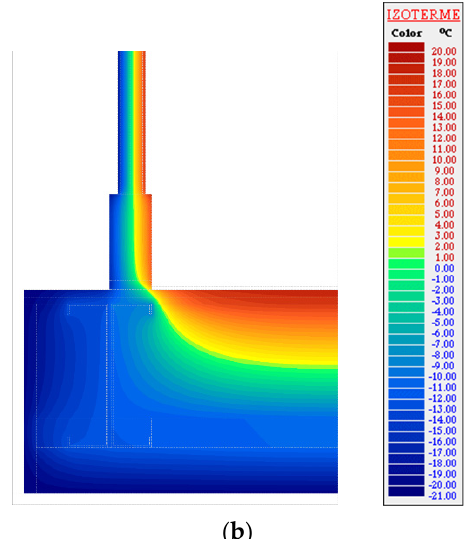
Figure A5. Curtain glass-floor in contact with the exterior: ( a ) Geometrical models; ( b ) Isothermal surfaces.